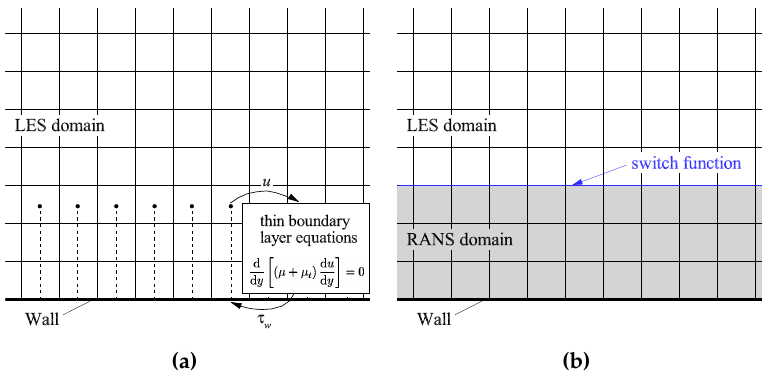
Figure 2. Implementation of ( a ) WMLES and ( b ) DES method on OpenFOAM